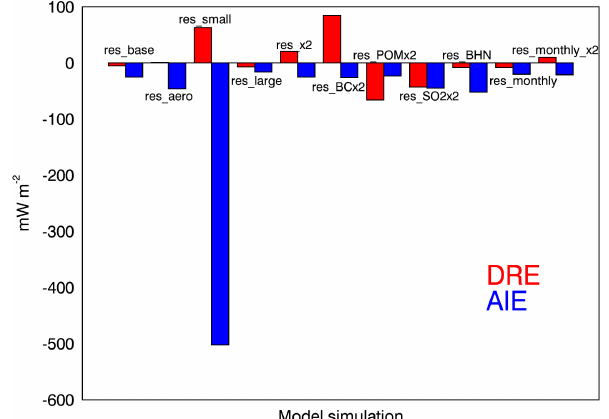
Figure 15. Global annual mean all-sky direct radiative effect (DRE) (red) and first aerosol indirect effect (AIE) (blue) for all model sim- ulations due to the impact of residential combustion emission, rel- ative to simulations where residential combustion emissions have been removed. DRE and AIE values for each simulation are detailed in Table